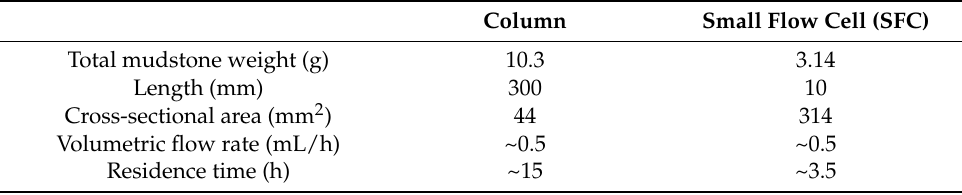
Table 2. Comparison of the physical parameters for the different flow equipment.